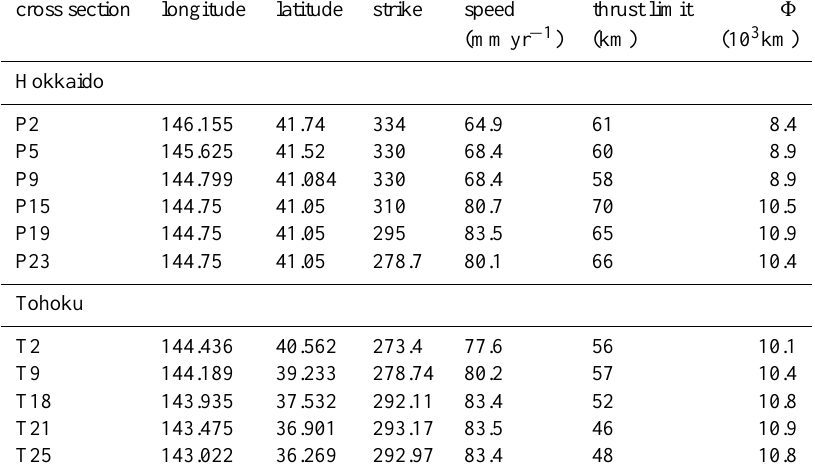
Table 1. Starting longitude (E) and latitude (N), strike, effective convergence speed, thermal parameter, and down-dip limit of the thrust zone for each cross section. The convergence speed is based on the projection of the convergence velocity onto the cross section. We use the Pacific-North America convergence velocity from NUVEL1-A (DeMets et al., 1994) computed using http://sps.unavco.org/crustal motion/ dxdt/nnrcalc/. The thermal parameter 8 is defined by age times speed. cross section longitude latitude strike speed thrust limit 8 (mmyr − 1 ) (km) (10 3 km)